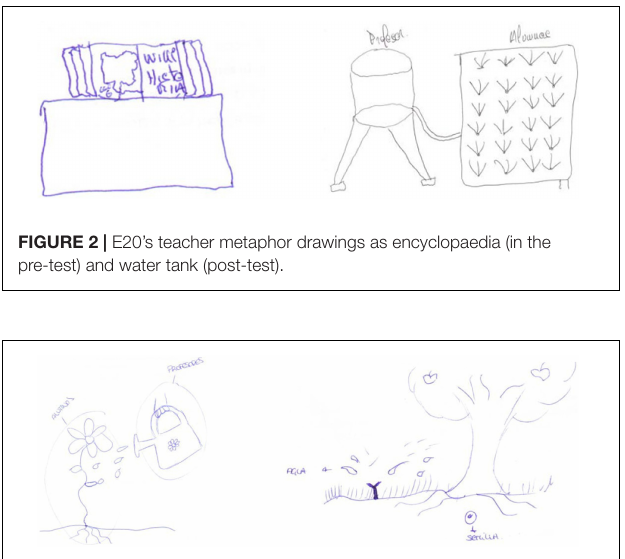
a complement to the metaphor of the pupil as a seed (Gurney, 1995; Saban, 2010).